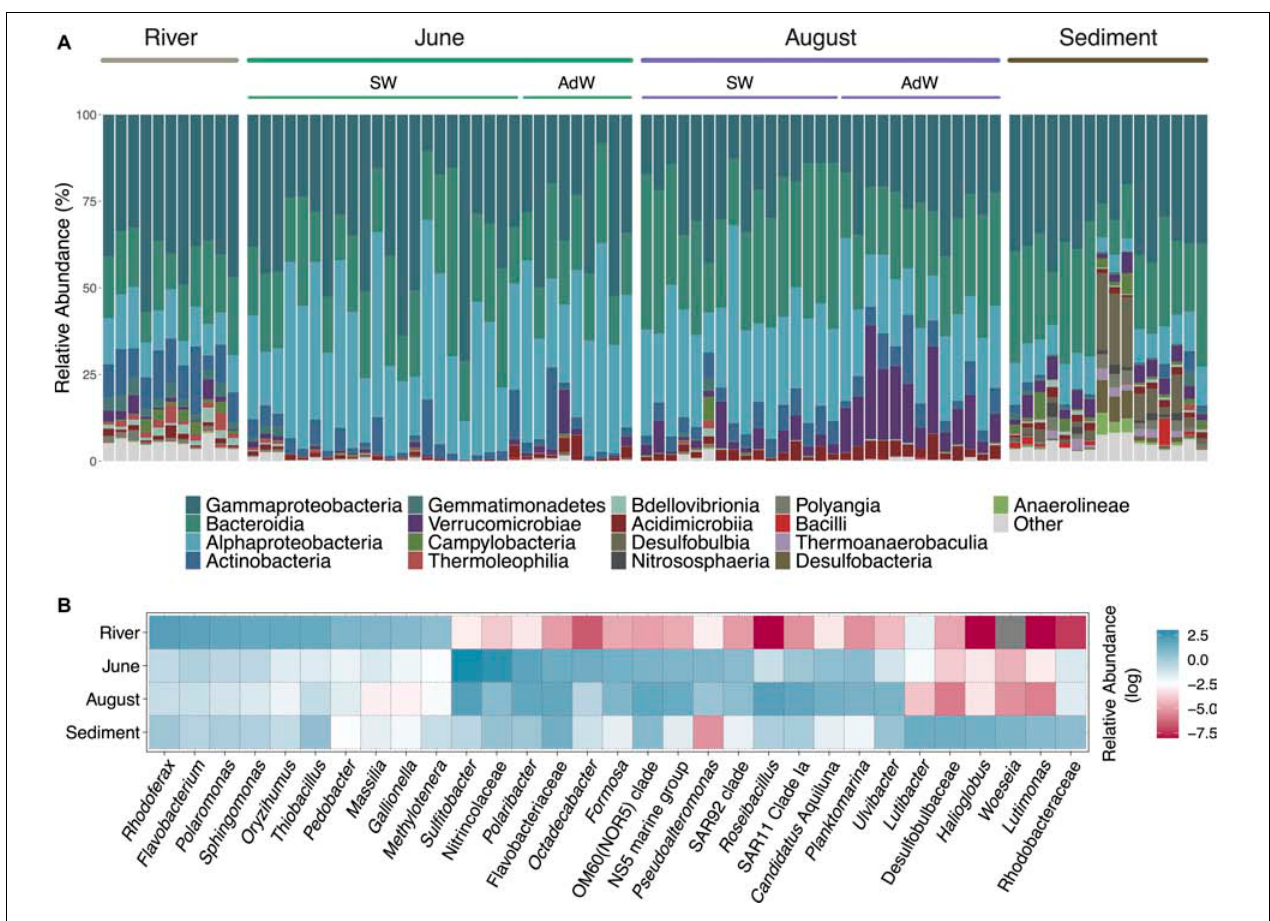
FIGURE 4 | Taxonomic affiliation of abundant taxa. (A) Stacked barplot showing the bacterial relative abundance of the most abundant classes. For water column samples, the sampling month is indicated above the plot, and samples are further separated between surface waters (SW) and advected waters (AdW). A table summarizing relative abundances of these classes according to month and water type is provided in the Supplement ( Supplementary Table 5 ). (B) Heatmap showing the mean relative abundances of the most abundant genera for each habitat and month in the water column. Relative abundances are shown on a log-scale for higher resolution. A high relative abundance is indicated by a blue color, a lower abundance is indicated by a red color, and a gray color indicates the absence of the